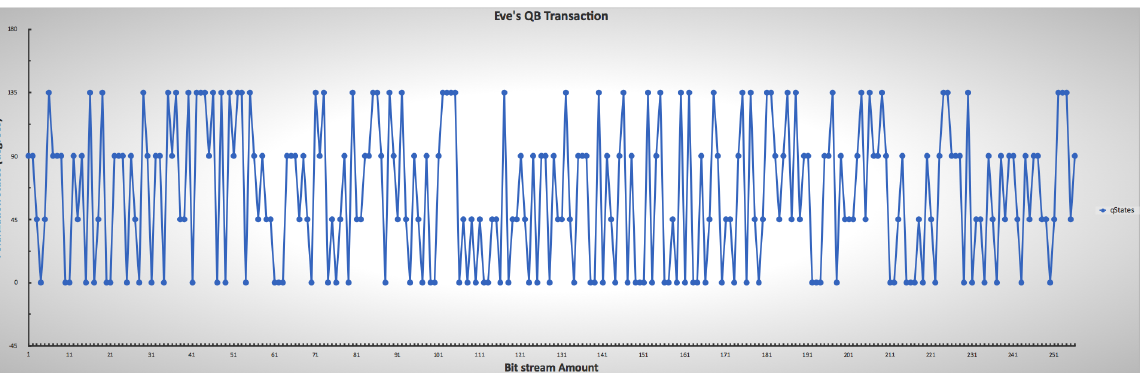
Figure 14. Eve’s lower and upper limit ranges for mimicking photon measurement and chosen encoding through polarization, indicating the randomness of Eve’s